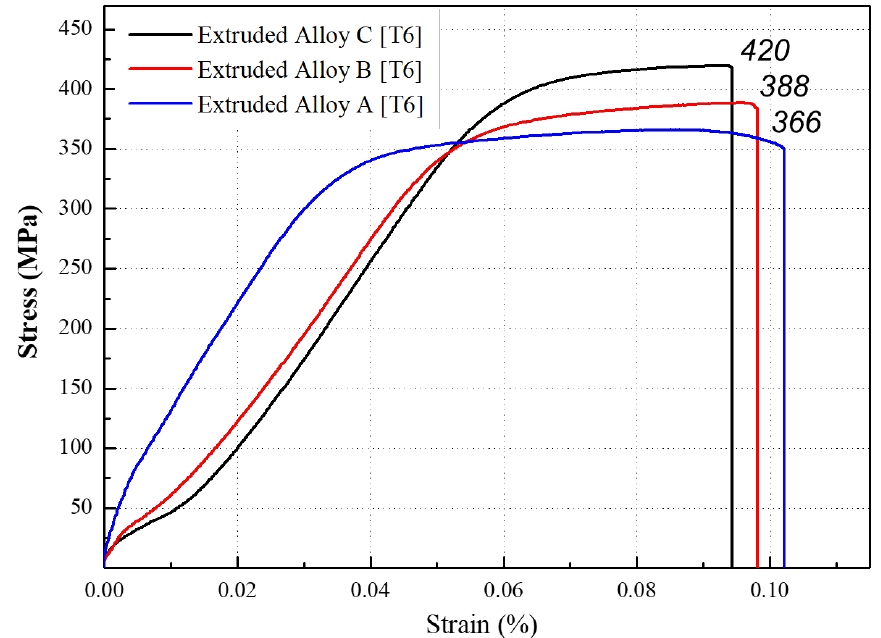
Figure 7. Comparison of tensile strength between the Al-XSi-3Cu-0.6Mg-0.5Fe [X = (a): 10, (b): 12.6, (c): 14] extruded alloys after T6 heat treatment.